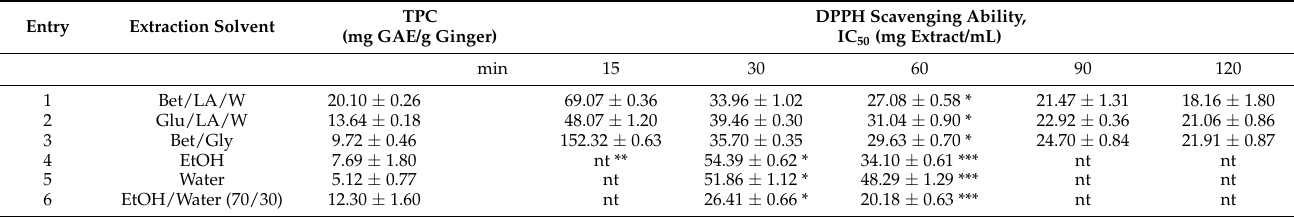
Table 7. Expanding the scope of the study using two more NaDESs and conventional solvents. The extraction conditions where the optimum proposed by the DOE (23.8 min, 60 Watt and 25:1 w/w NaDES/dry ginger.). Entry Extraction